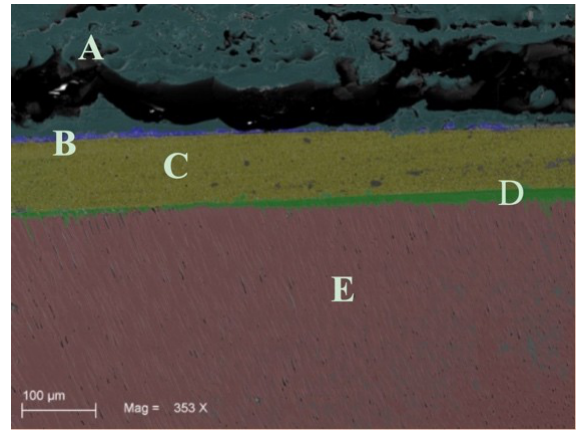
Figure 2. Image of Group 1. This image shows the interaction between the impression material and oxygen-inhibition layer (OIL). The letters indicate the different identifiable layers: (A) impression material; (B) interfering OIL layer with the impression material; (C) composite resin; (D) adhesive layer (it is possible to see the points where it penetrates into the tubules); (E) dentin.